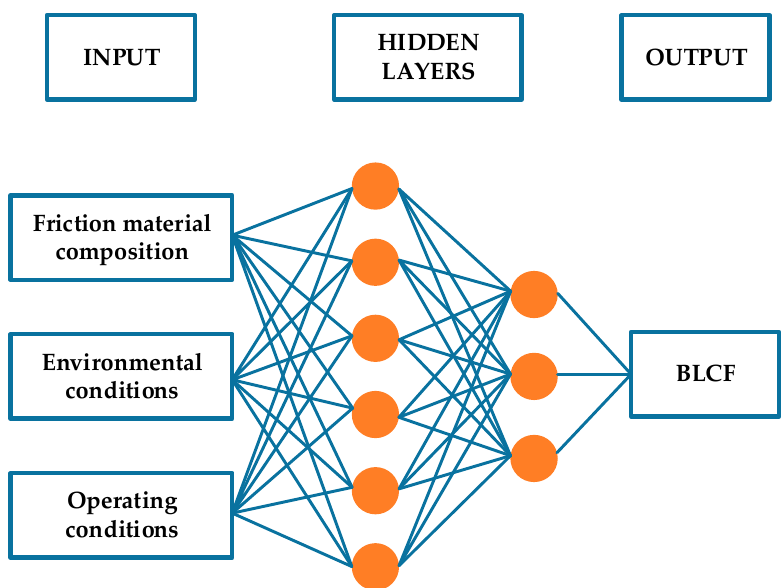
Figure 9. Artificial neural network for BLCF estimation.